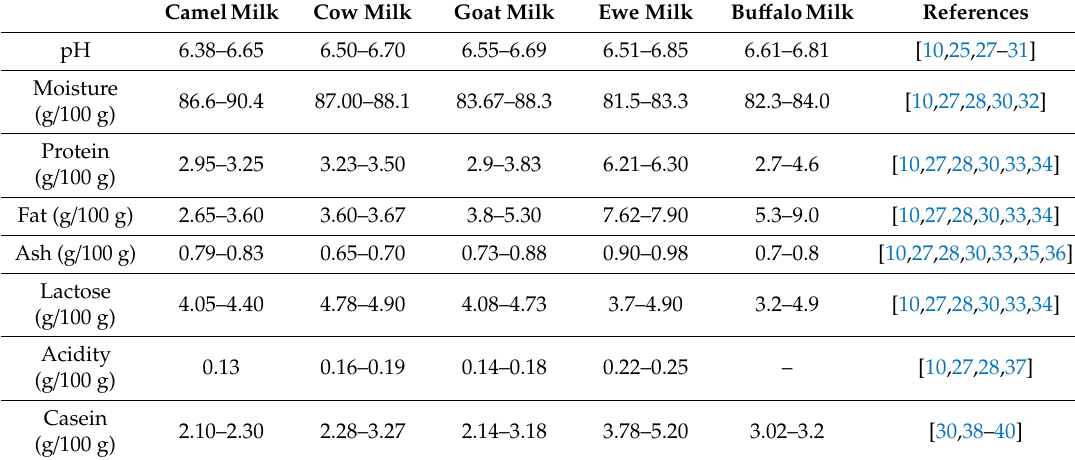
Table 1. Approximate composition of milk from the various